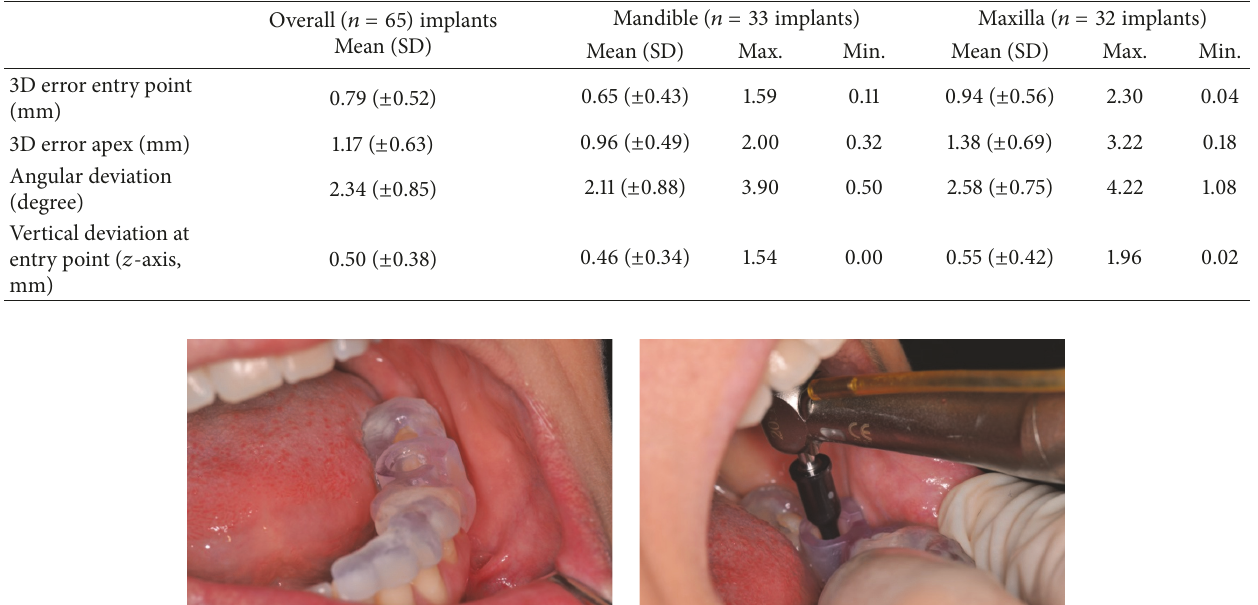
Table 1: Discrepancy values at entry point, apex, angular deviation, and vertical deviation.